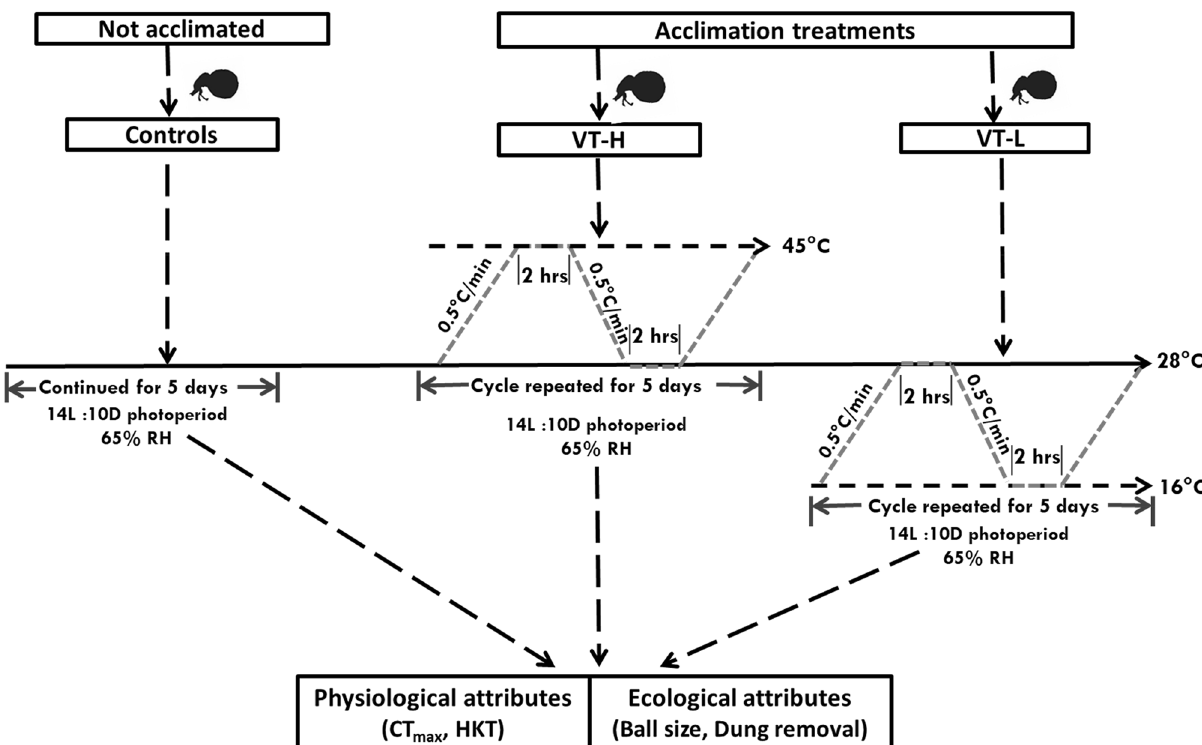
Figure 3. Schematic representation of variable temperature acclimation treatments at a ramping rate of 0.5 °C/ min from a benign temperature of 28–45 °C (VT-H) and to 28–16 °C (VT-L) at 65 ± 10% RH and 14D:10L photoperiod. Control beetles were maintained at a constant 28 °C, 65 ± 10% RH and 14D:10L